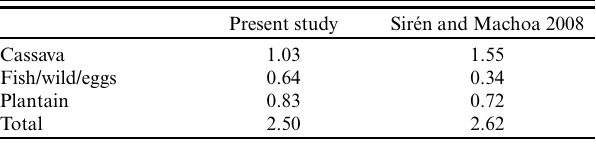
Table 5 . Food supply in kg/capita day ⁻ ¹; raw material. Comparison between present study and another study made in